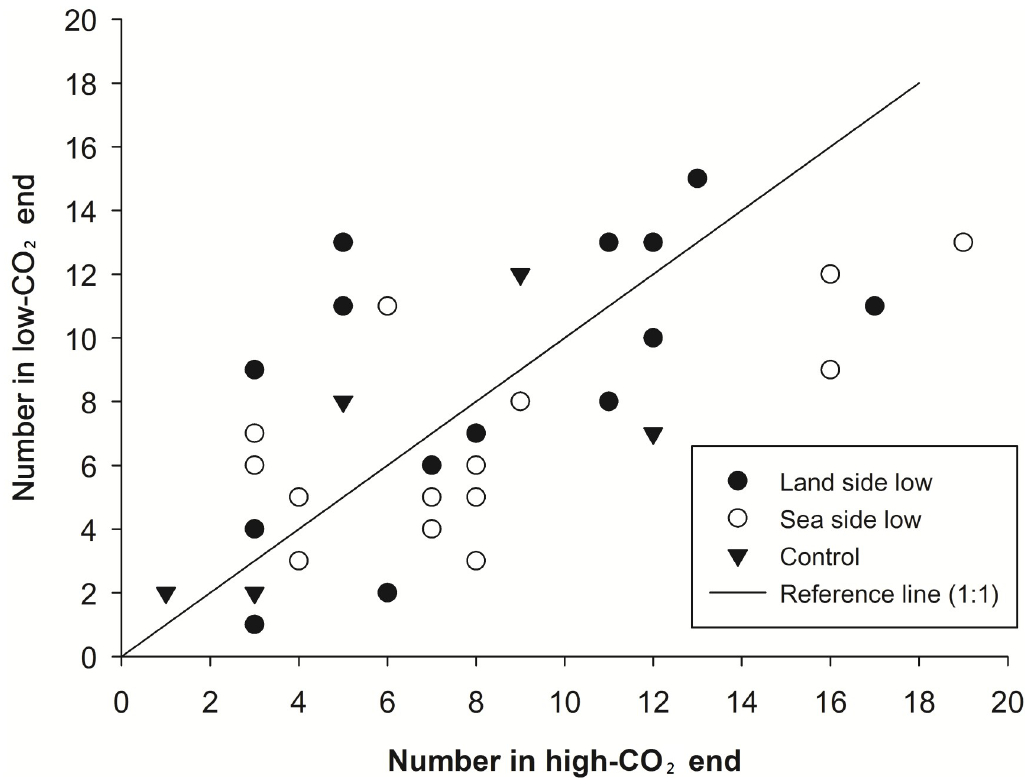
Fig 5. Distribution of midges ( Pontomyia oceana ) at the two ends in the CO 2 gradient experiment. No difference was found between the two ends in any group. Treatments sharing the same alphabets have no significant differences among each other.